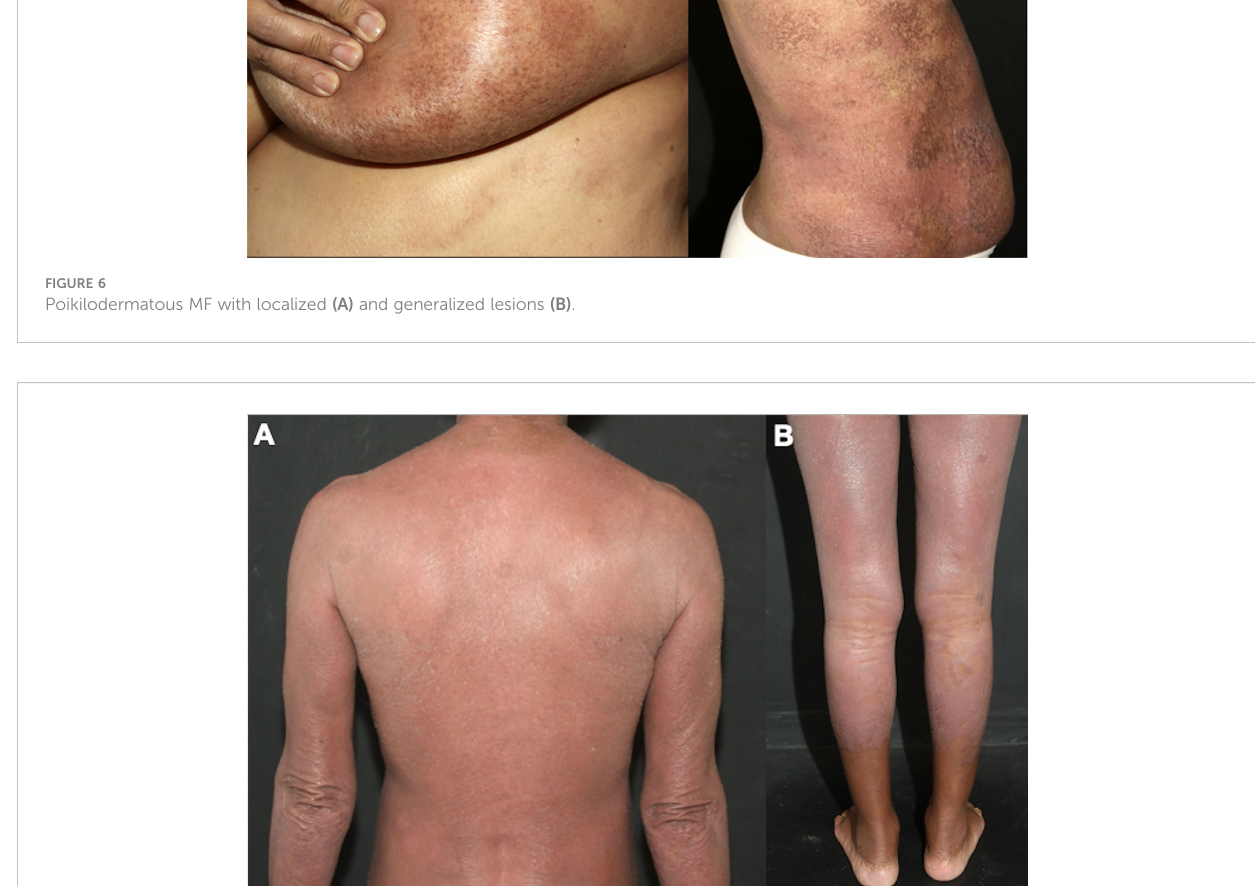
FIGURE 7 Erythrodermic MF. Difuse erythema and scaling affecting on the back and arms (A) , and on the lower limbs (B)